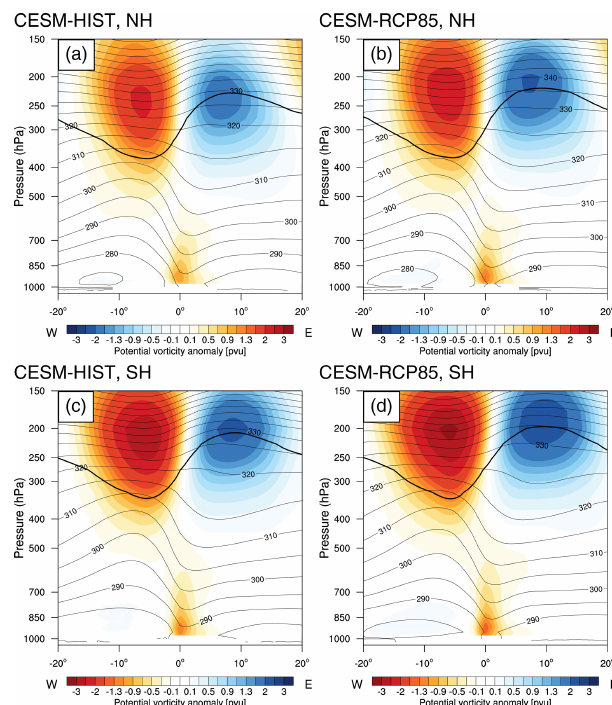
Figure 9. West–east-oriented cross section across the centre of the composite cyclone, in the middle of the 24h period of strongest deepening, showing the PV anomaly (pvu; shading), the 2pvu con- tour (thick black contour), and potential temperature (thin black contours every 5K). The fields are shown for (a, b) NH winter and (c, d) SH winter in (a, c) CESM-HIST and (b, d)